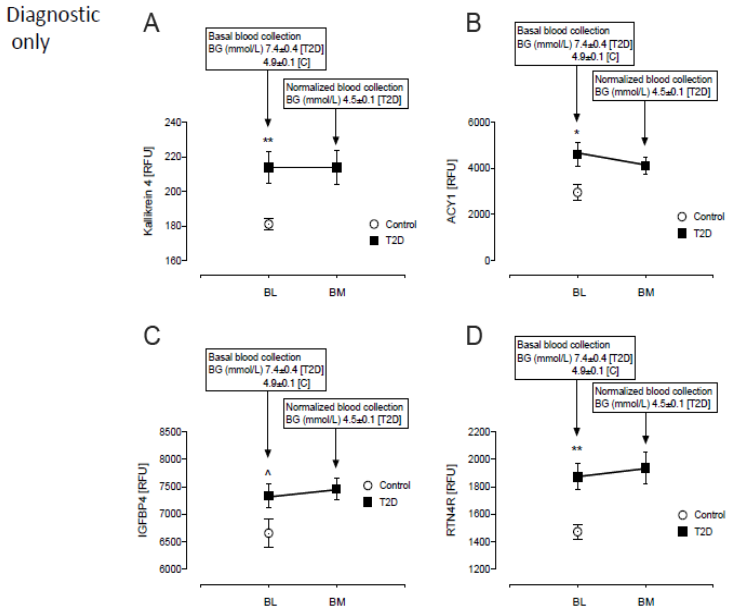
Figure 2. Comparison of only the diagnostic proteins of β -cell dysfunction in plasma at BL and post-iatrogenic induction of euglycemia (BM) for the T2D subjects. Blood sampling for proteomics was performed at baseline (BL) in controls (white circles) and T2D (black squares) and again at euglycemia (BM) in T2D subjects only. Proteomic (Somalogic) analysis of diagnostic proteins of β -cell dysfunction was undertaken for Kallikrein-4 (KLK4) ( A ), Aminoacylase-1 (ACY1) ( B ), Insulin-like growth factor-binding protein-4 (IGFBP4) ( C ) and Reticulon-4 receptor (RTN4R) ( D ). ^ p < 0.05; * p < 0.01; ** p < 0.001. BG, blood glucose; RFU, relative fluorescent units; T2D, type 2 diabetes.